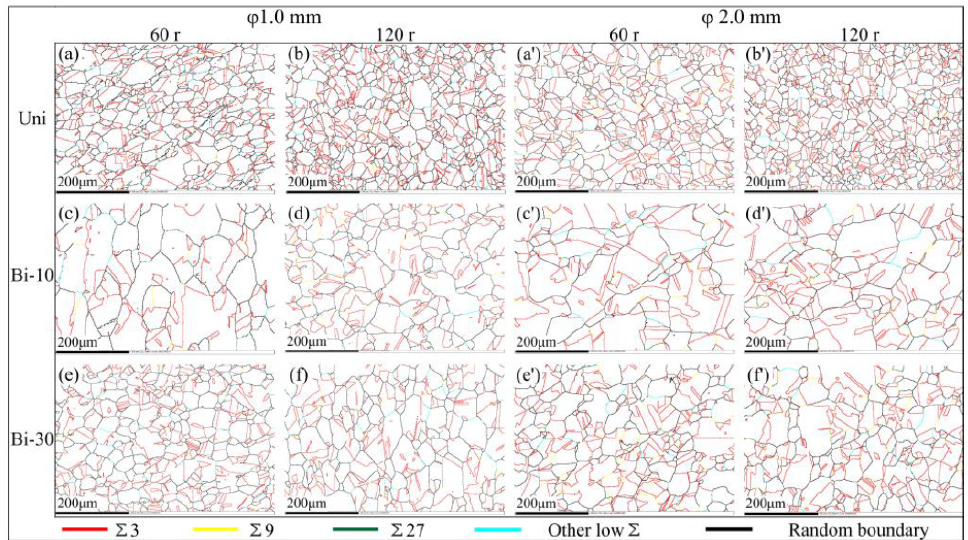
Figure 3. GBCD of samples: ( a ) φ 1-Uni-1, ( b ) φ 1-Uni-2, ( c ) φ 1-Bi-10-1, ( d ) φ 1-Bi-10-2, ( e ) φ 1-Bi-30-1, ( f ) φ 1-Bi-30-2, ( a’ ) φ 2-Uni-1, ( b’ ) φ 2-Uni-2, ( c’ ) φ 2-Bi-10-1, ( d’ ) φ 2-Bi-10-2, ( e’ ) φ 2-Bi-30-1, ( f’ ) φ 2-Bi- 30-2.